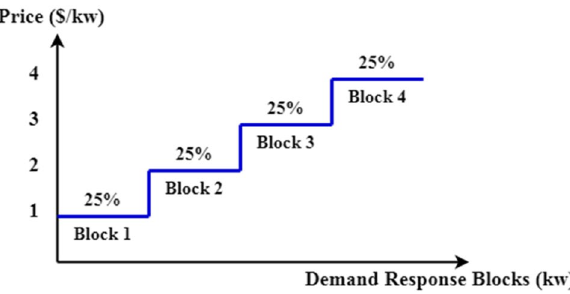
Figure 6. The step cost of EDRP program in the MG formation